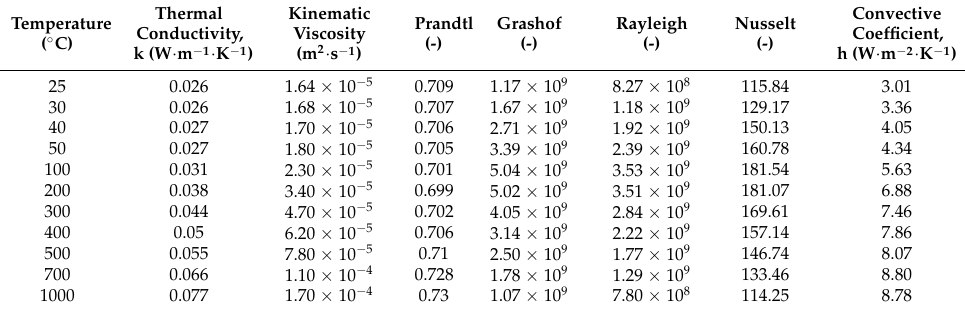
Table 2. Derived thermal conductivity, viscosity, Grashof, Rayleigh, Nusselt numbers and convective coefficient, from first principles, for a range of air